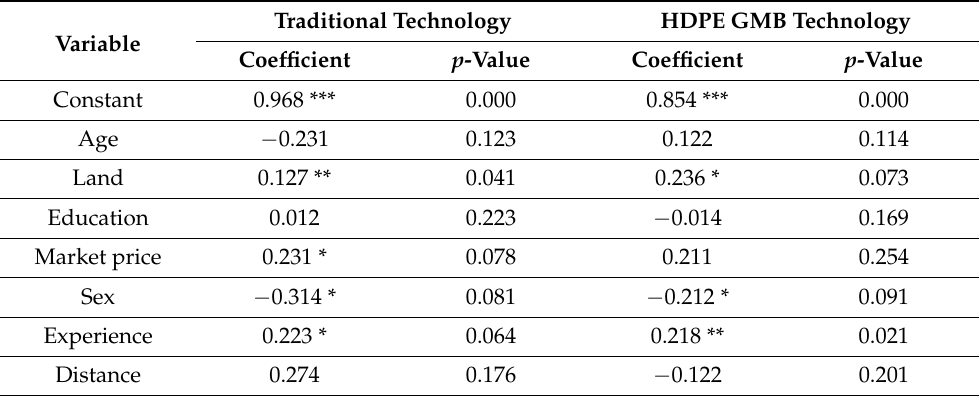
Table 7. Parameter estimates of the inefficiency